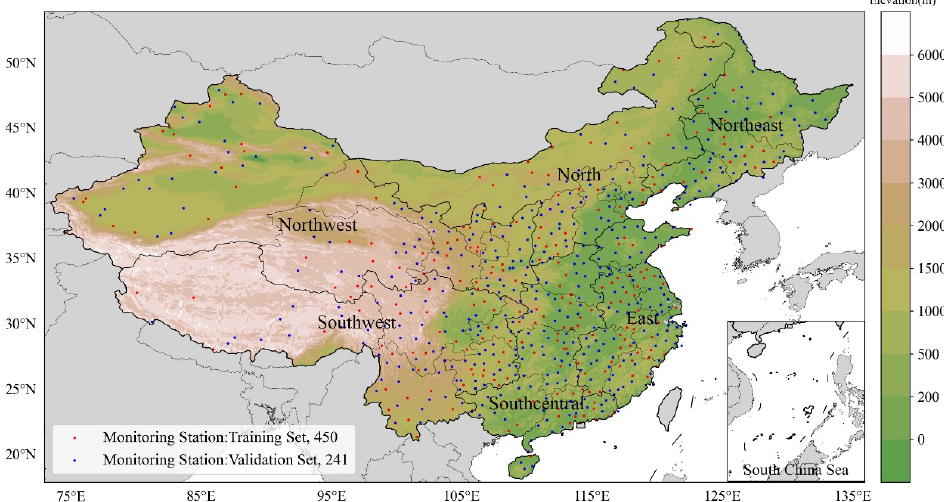
Figure 1. Domains of six geographical divisions—north (N), which consists of Beijing, Tianjin, Hebei, Shanxi, and Inner Mongolia; northwest (NW), which consists of Xinjiang, Qinghai, Gansu, Ningxia, and Shaanxi; northeast (NE), which consists of Heilongjiang, Jilin, and Liaoning; southwest (SW), which consists of Tibet, Yunnan, Sichuan, Chongqing, and Guizhou; south central (SC), which consists of Henan, Hubei, Hunan, Guangdong, and Guangxi; and east (E), which consists of Shandong, Anhui, Jiangsu, Shanghai, Zhejiang, Jiangxi, and Fujian—as well as meteorological stations. Four sets of random validation stations were selected to make their distribution more uniform. Containing 10% of all stations (of a total of 69), each set randomly selects one day of the month to apply, for a total of four days per month using only interpolation points for interpolation.